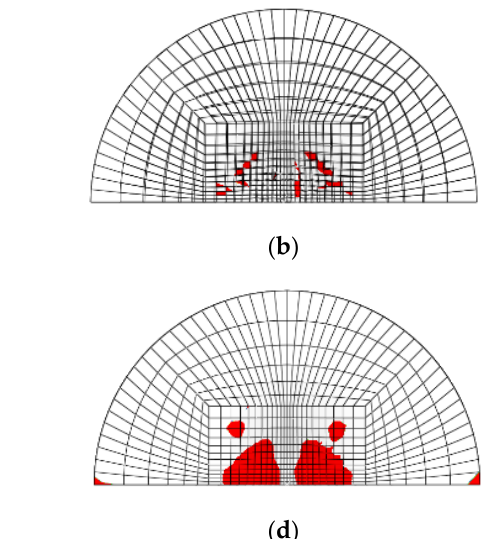
Figure 23. Fiber tension failure (FTF) in the composite layers of GLARE 5-2/1 with [0 ° /90 ° /90 ° /0 ° ] after applying the second